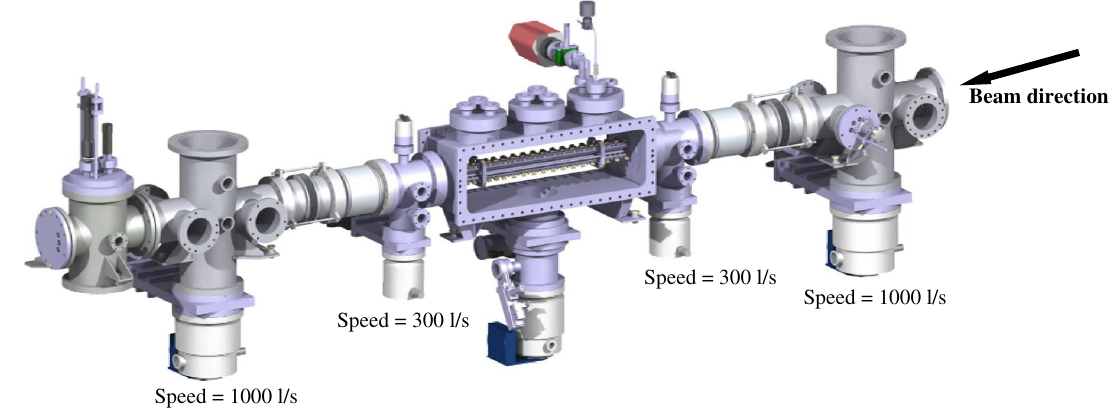
FIG. 2. 3D layout of the differential pumping vacuum system of SHIRaC.